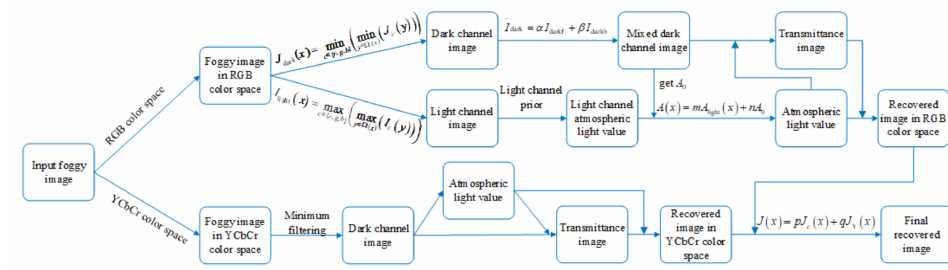
Figure 1. Flow chart of the proposed